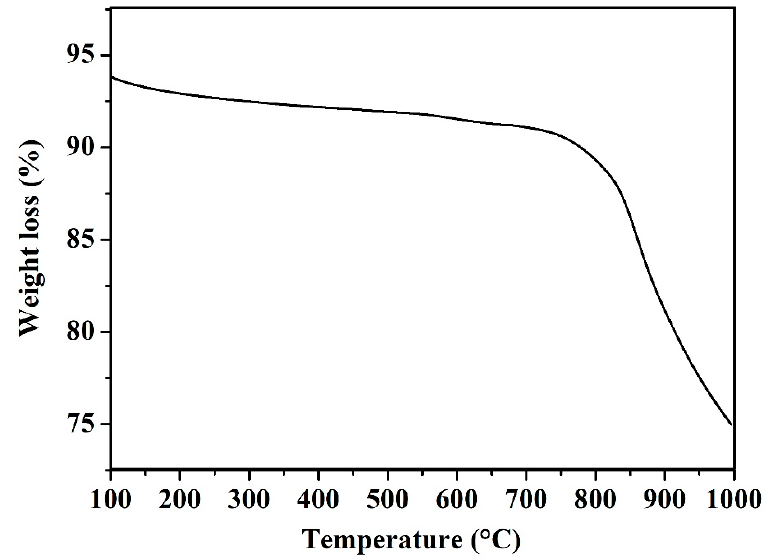
Figure 6. TGA (thermogravimetric analysis) of hybrid CNTs.